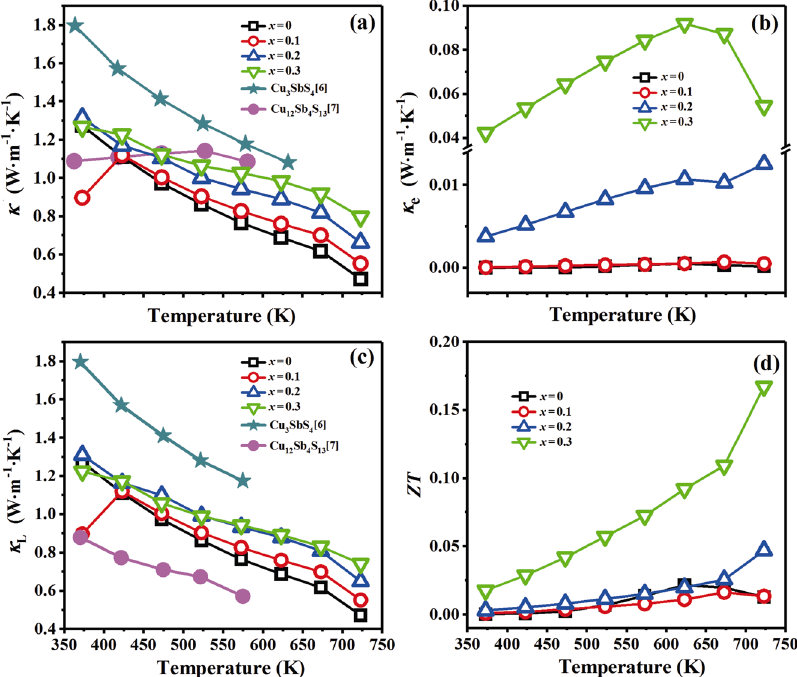
Fig. 7 Temperature dependence of thermal transport properties and ZT value for the bulk samples with the mole ratio of (1– x )CuSbS 2 – x Cu 1.8 S ( x = 0, 0.1, 0.2, 0.3): (a) thermal conductivity ( κ ), (b) electronic thermal conductivity ( κ e ), (c) lattice thermal conductivity ( κ L ), and (d) ZT